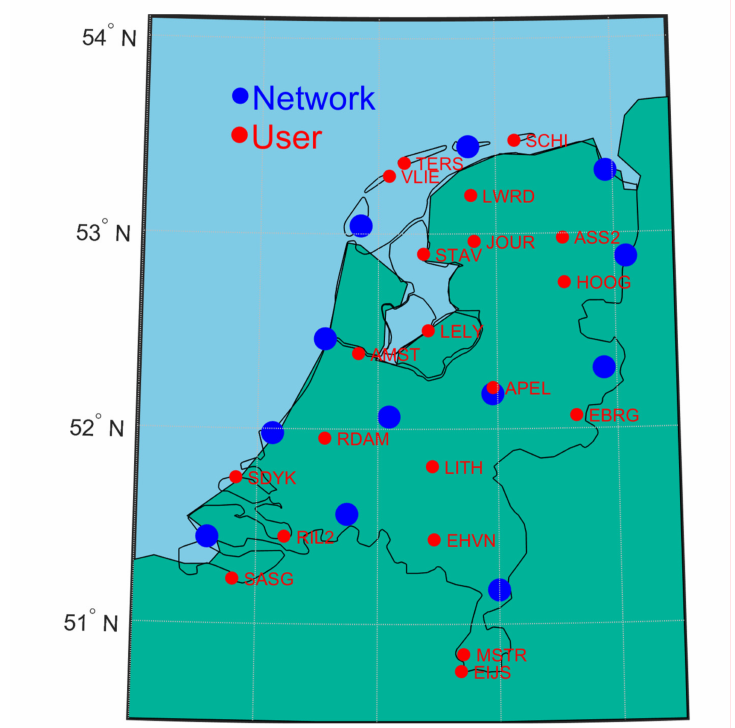
Figure 1. Global navigation satellite system (GNSS) network of the Netherlands, where blue points represent reference stations and red points are user